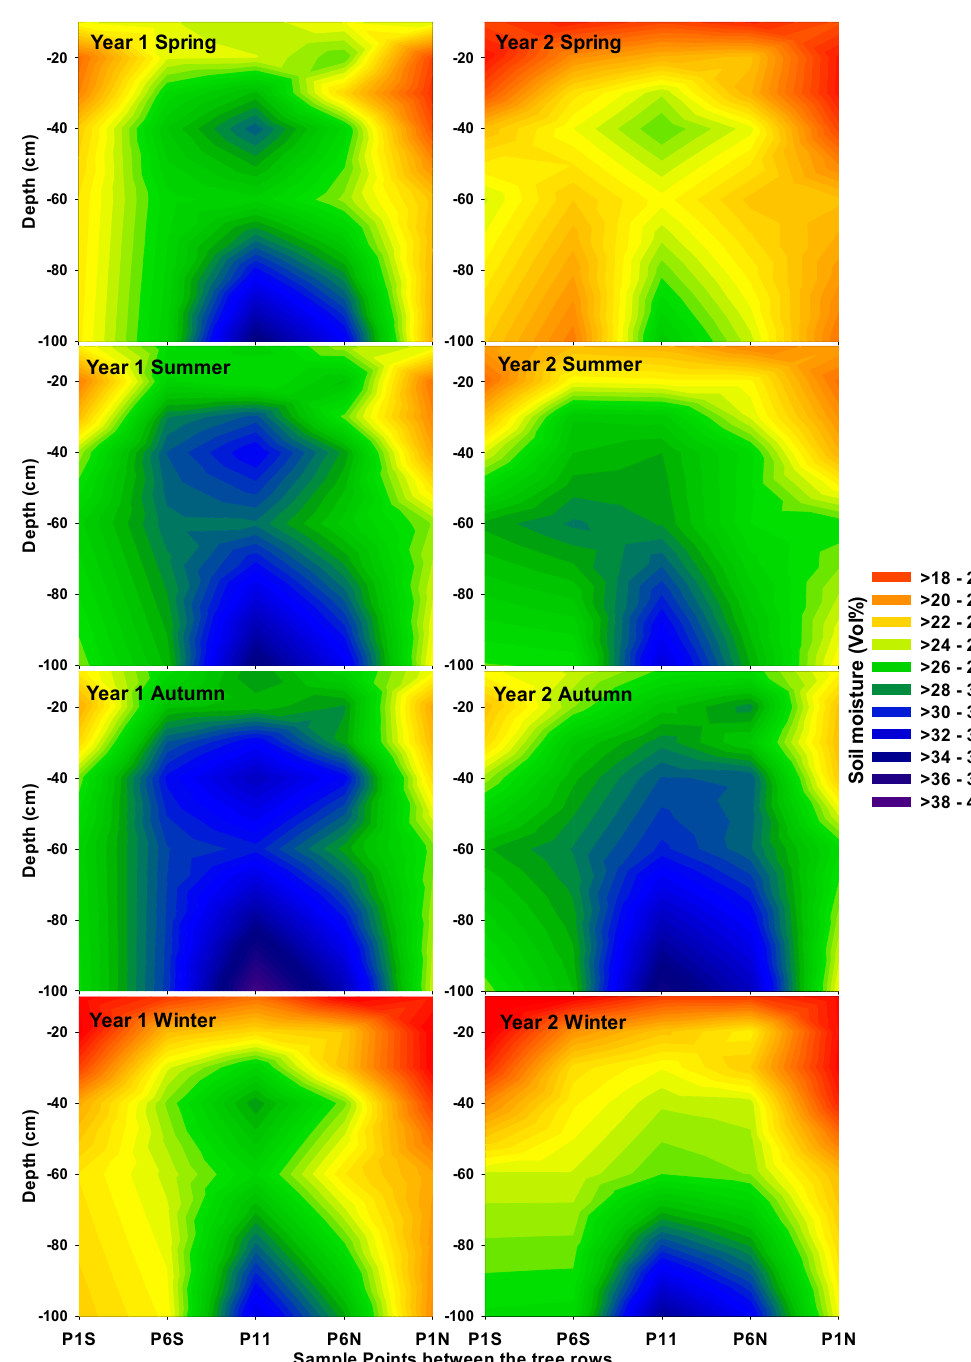
Figure 5. Mean soil moisture (SM, in Vol%) for each sample point between the tree rows. Left panel shows SM for spring, summer, autumn and winter of year 1 and the right panel shows SM for spring, summer, autumn and winter of year 2. P1S: 1 m and P6S: 6 m from southern row. P1N: 1 m and P6N: 6 m from northern row. P11: 11 m from southern and northern row respectively. Analysis of variance showed significant differences in SM between years (except for 60 cm depth), seasons and sample points at all measured depths (Table 2). Whereas in the topsoil at 10 cm depth, season had the largest effect on SM, the influence of the sample point became larger with increasing soil depth.